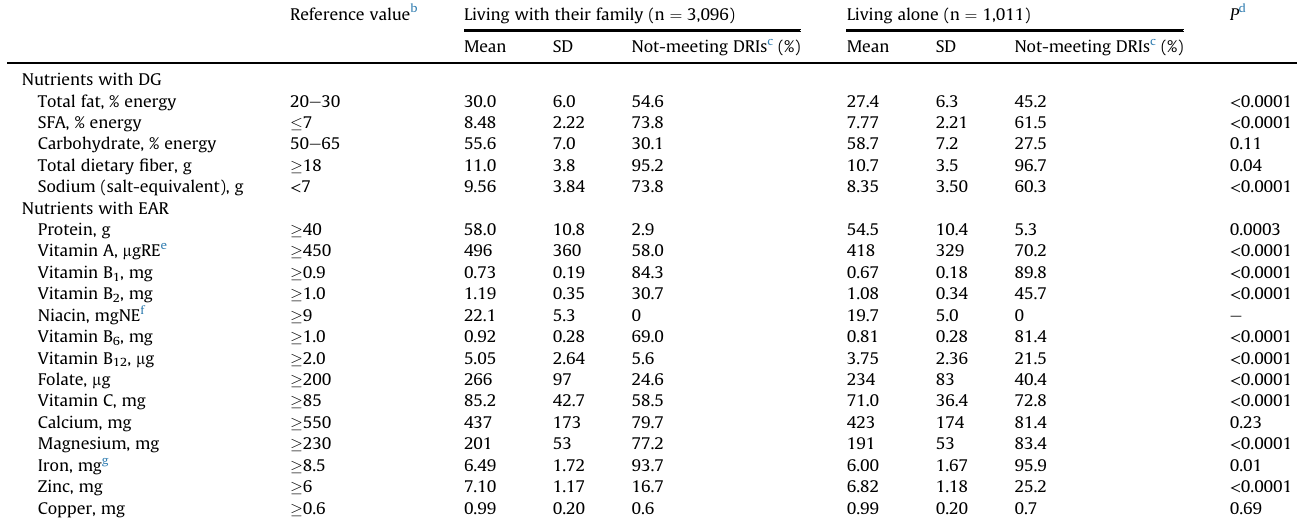
Table 2 Daily nutrient intakes and prevalence of not-meeting DG and EAR among 4,107 adult women living with their family or living alone. a Reference value b Living with their family (n ¼ 3,096) Living alone (n ¼ 1,011)